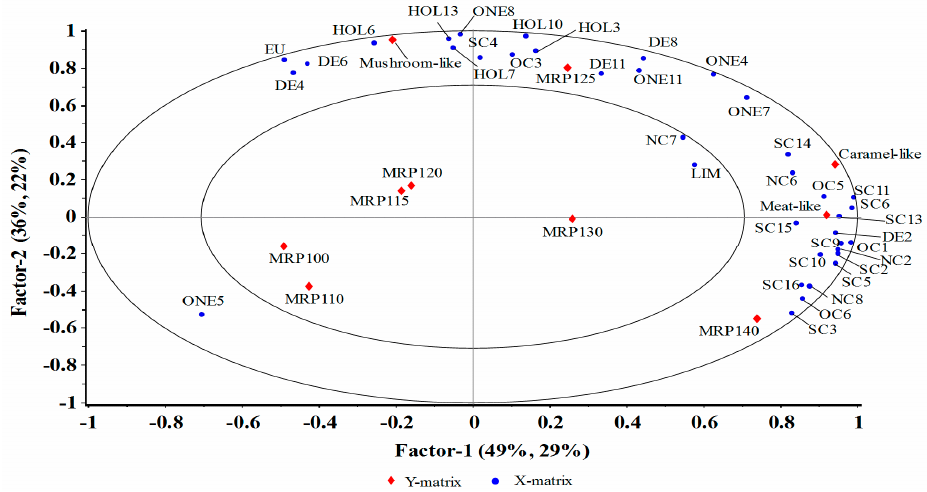
Figure 2. The correlation loadings plot for MRPs samples by partial least squares regression analysis. X -matrix = GC/MS analysis; Y -matrix = MRPs samples and sensory evaluation data.